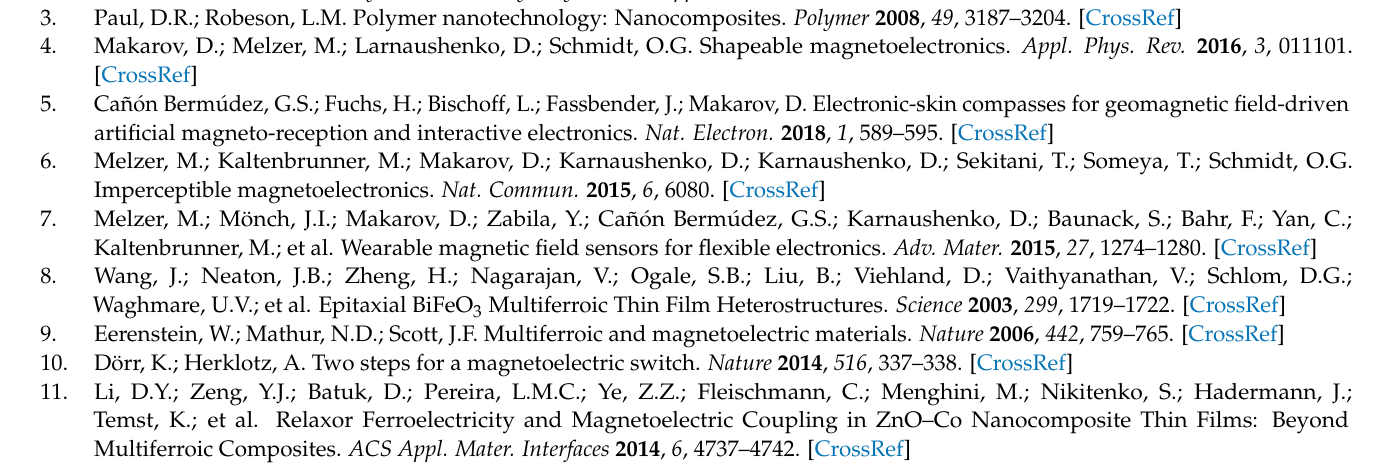
tion characteristics of the studied samples; Figure S3: XRD spectra; Figure S4: Agglomerates ImageJ analysis; Figure S5: ImageJ processing and analysis of the SEM